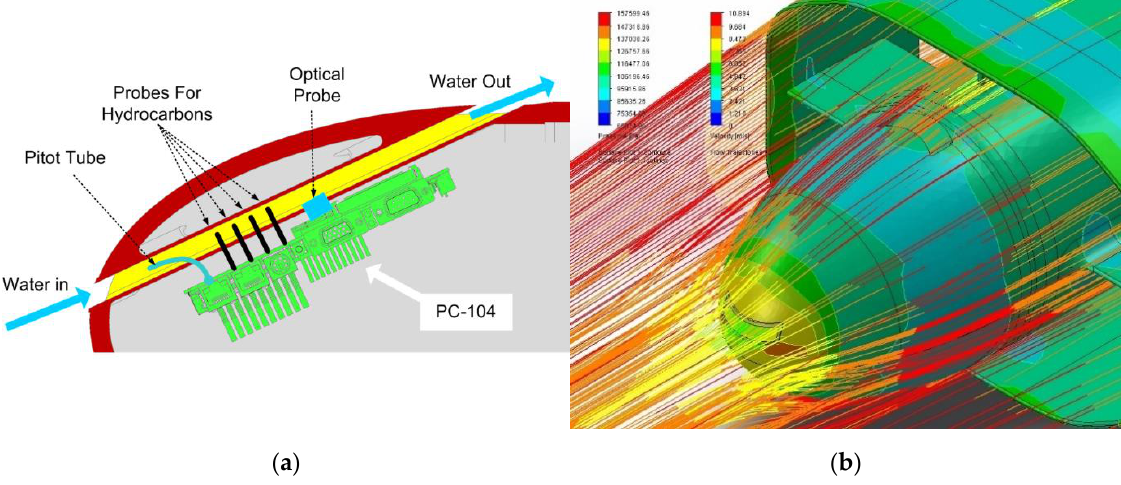
Figure 5. ( a ) Nostril: port cutaway side view; ( b ) simulation of the flow of water in the interference area between the nostril outlet and the annular